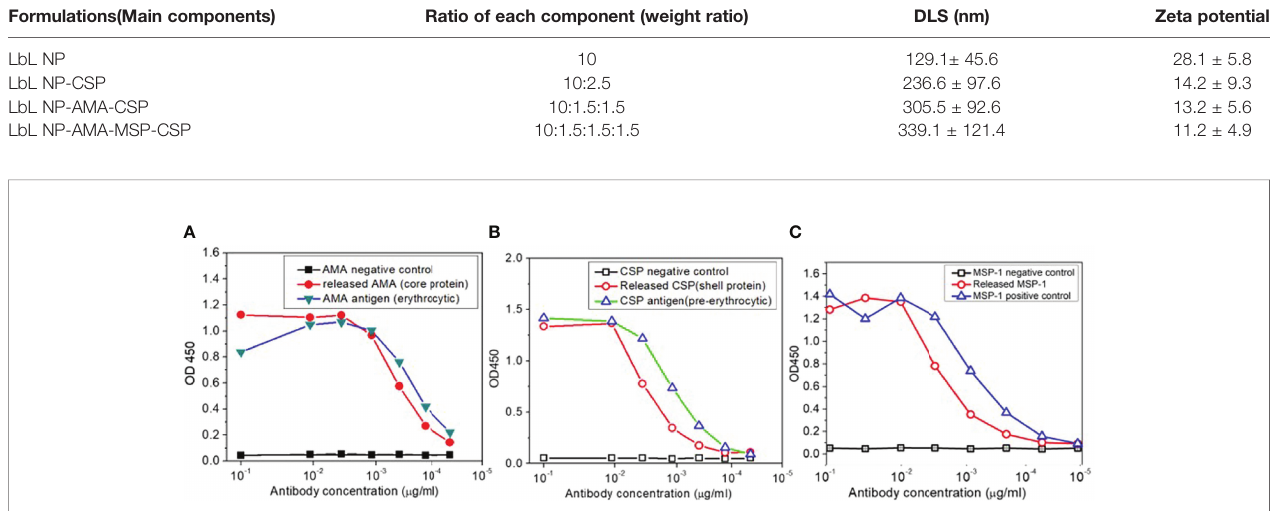
TABLE 3 | Parameters for the formulations for the ef fi cacy studies. Formulations(Main components)